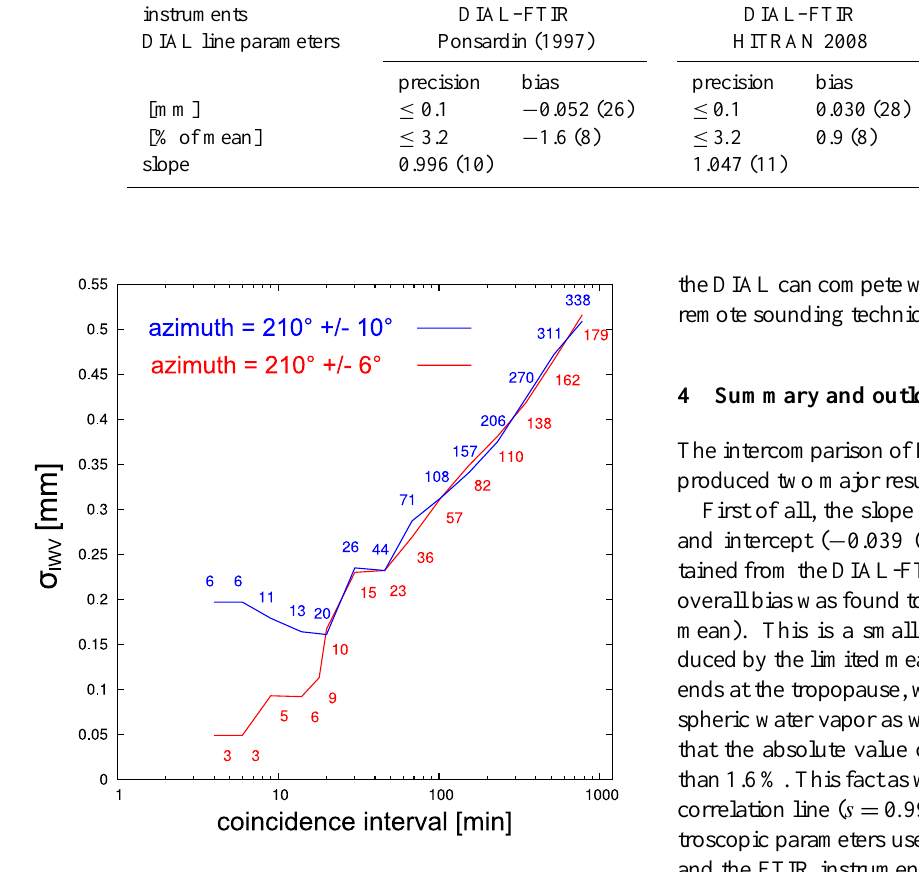
Fig. 3. The standard deviation of differences between DIAL and FTIR IWV values σ IWV as a function of the length of the coinci- dence interval. Only FTIR measurements within an azimuth interval of 210 ◦ ± 6 ◦ were taken into account for the lower curve, while the upper curve is for an increased azimuth interval (210 ◦ ± 10 ◦ ). The numbers of coincident pairs are shown next to both